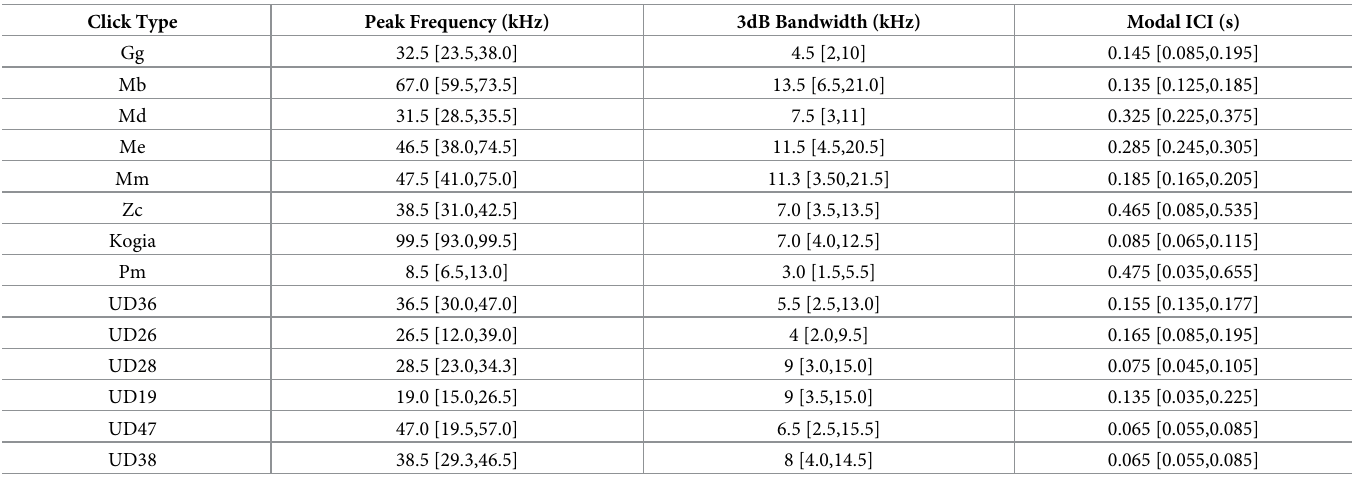
Table 2. Signal parameters peak frequency, 3dB bandwidth, and modal ICI for known species and novel click types given as median with 10th and 90th percentile in brackets. Names for known-type classes are abbreviations of the species/genus names: Gg: Grampus griseus ; Mb: Mesoplodon bidens ; Md: Mesoplodon densirostris ; Me: Mesoplodon europaeus ; Mm: Mesoplodon mirus ; Zc: Ziphius cavirostris ; Kogia: Kogia spp .; Pm: Physeter macrocephalus